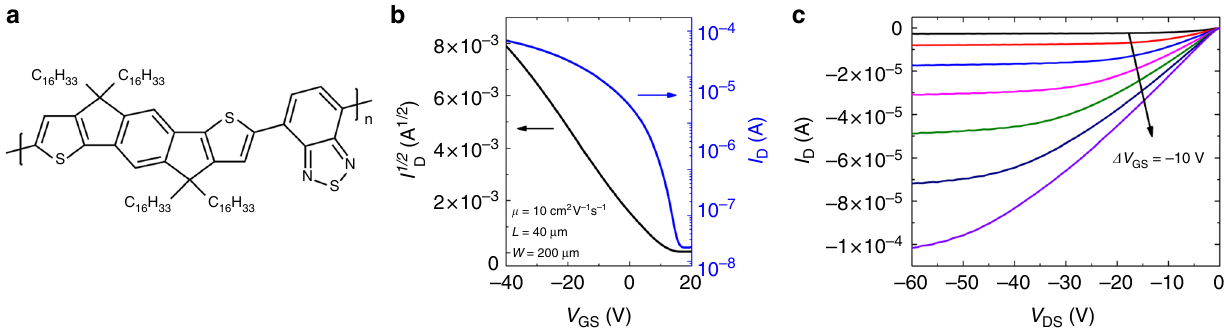
Fig. 6 Electrical properties of C 16 IDT-BT devices. a Chemical structure of C 16 IDT-BT copolymer. b Drain current as a function of gate-source voltage for a C 16 IDT-BT device in the saturation regime ( V DS = − 40V). c Drain current as a function of drain-source voltage for the same